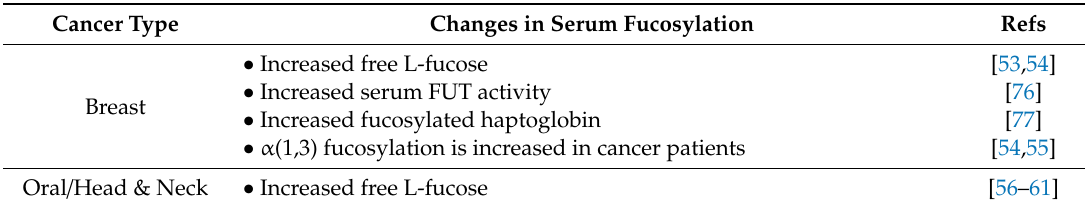
Table 3. Altered serum fucosylation profiles in cancer